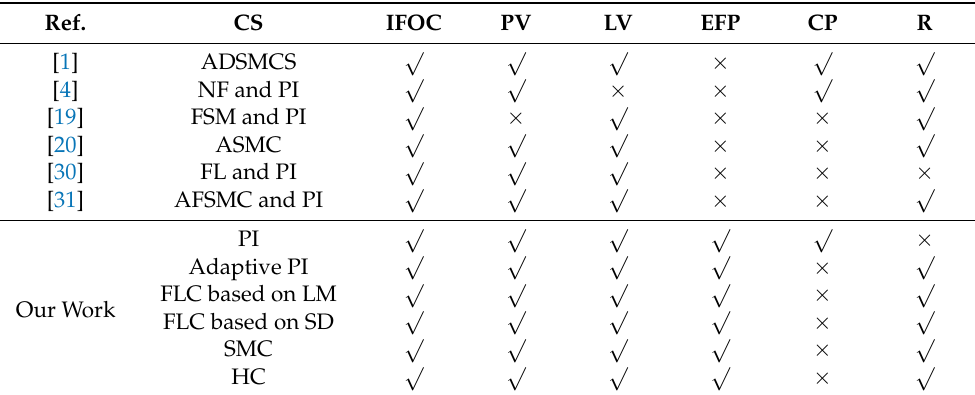
Table 2. Comparison of the designed control strategies with the